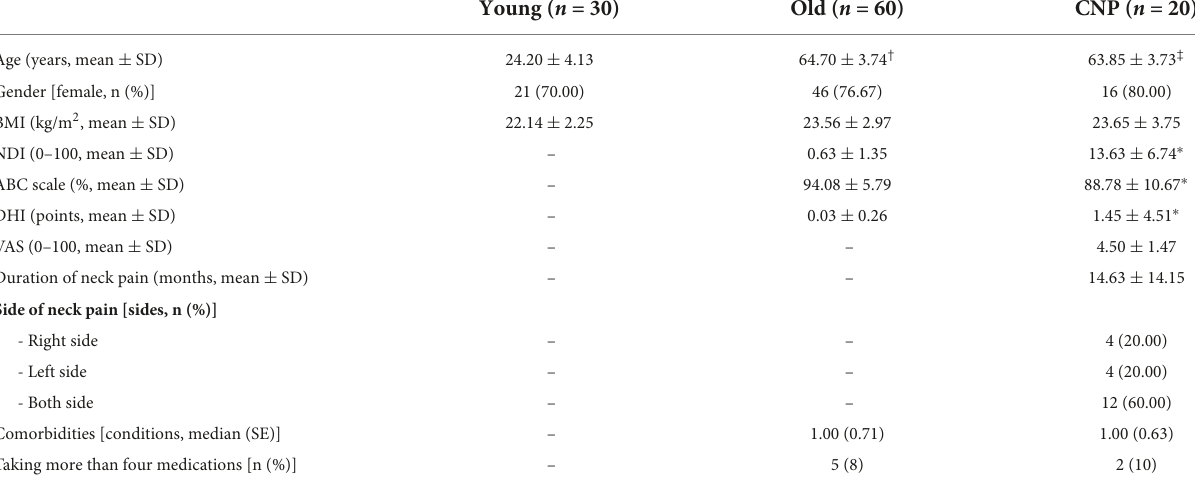
TABLE 1 Characteristic of